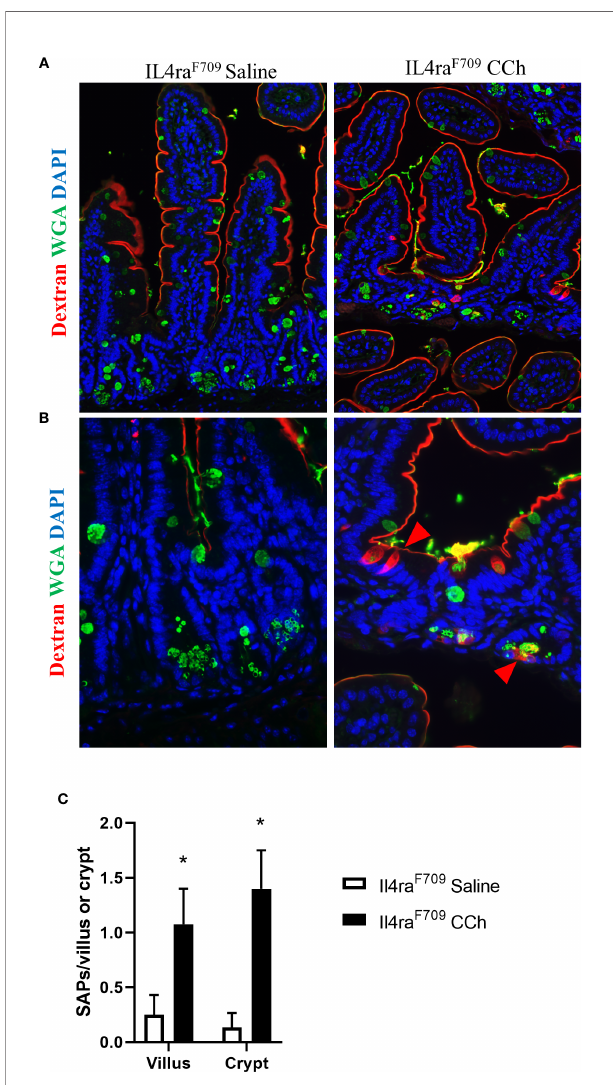
FIGURE 4 | Thermoneutral housing temperature alters structural patterning of antigen passage formation in Il4ra F709 mice. (A&B) Immuno fl uorescence analysis for WGA (green) and dextran (red) with the small intestine of Il4ra F709 mice treated with saline or CCh that are housed at the thermoneutral temperature. (A) shows a lower magni fi cation image and (B) shows a higher magni fi cation image. The nucleus is visualized with DAPI (blue). (C) Quanti fi cation of antigen passage formation for villi and crypts. n=2-3 per group. * denotes statistical signi fi